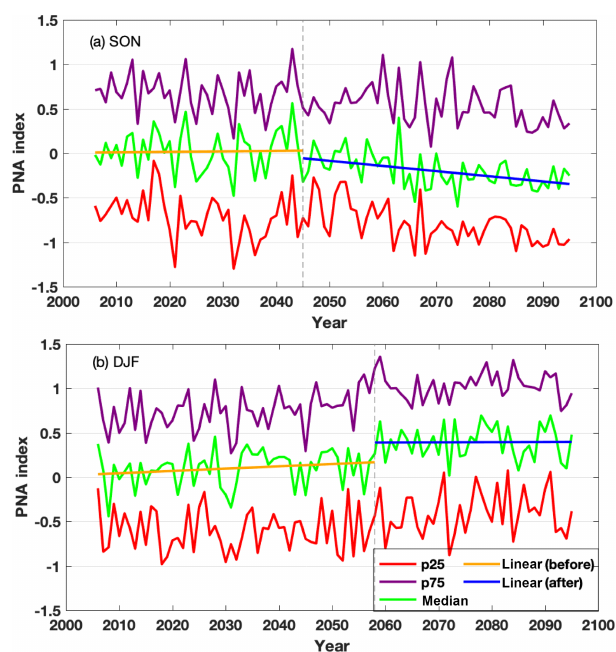
Figure 3. The (a) autumn (SON) and (b) winter (DJF) PNA in- dex over the 21st century computed by applying CMIP5 ensem- ble model information to the formula given in Wallace and Gut- zler (1981). The lines indicate the median, 25th percentile, and 75th percentile. Also shown are piecewise linear regression lines sepa- rated at the “break” year indicated by the dashed line. Assessments using the Mann–Kendall method (Kendall, 1955) show that the af- ter (before) break trend for SON (DJF) is significant at 5% (10%), while the other trends are not significant. The before and after break trends are significantly different at 5% (10%) for SON